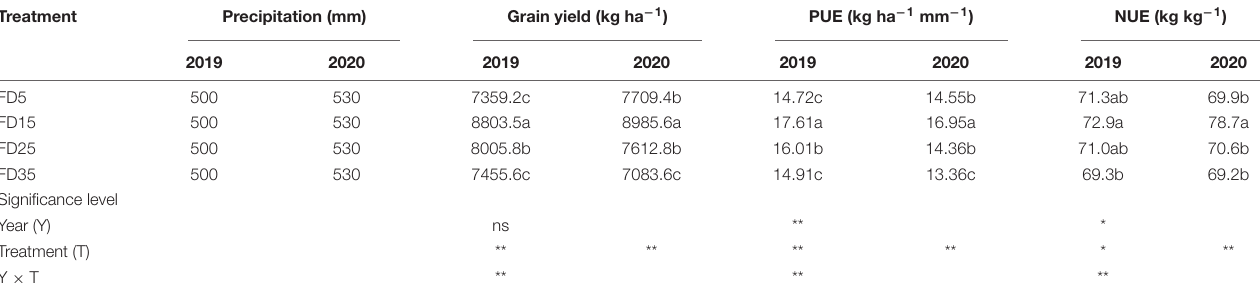
TABLE 2 | Precipitation in winter wheat season; grain yield, PUE, plant nitrogen (N) uptake, and NUE of winter wheat. Treatment Precipitation (mm)